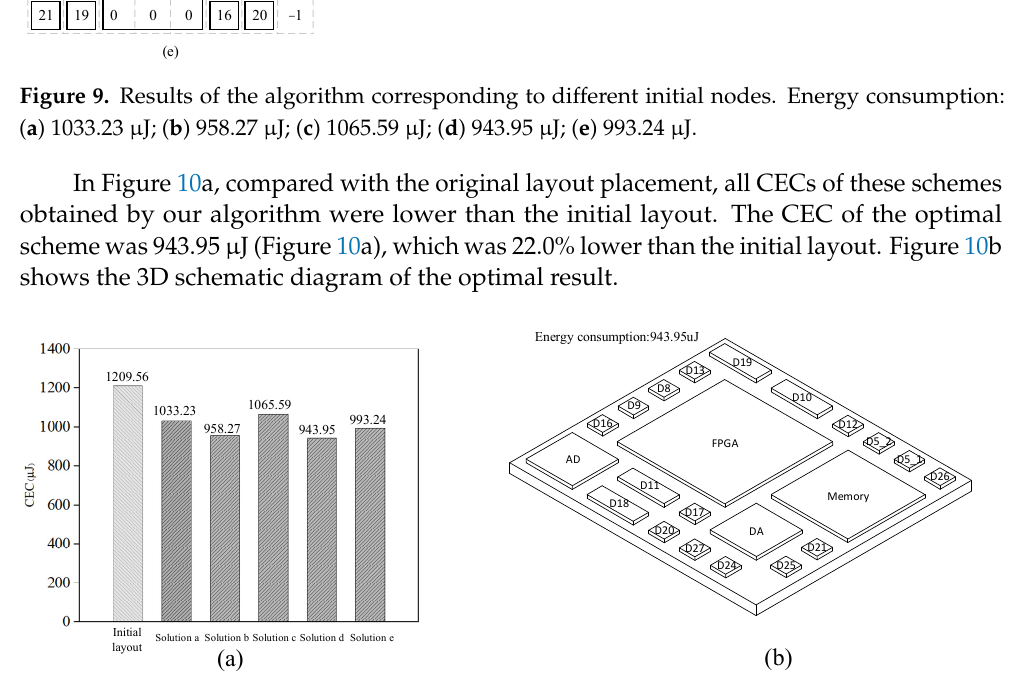
Figure 10. ( a ) Contrast of initial layout and CCEOA results; ( b ) 3D schematic diagram of the optimal result.